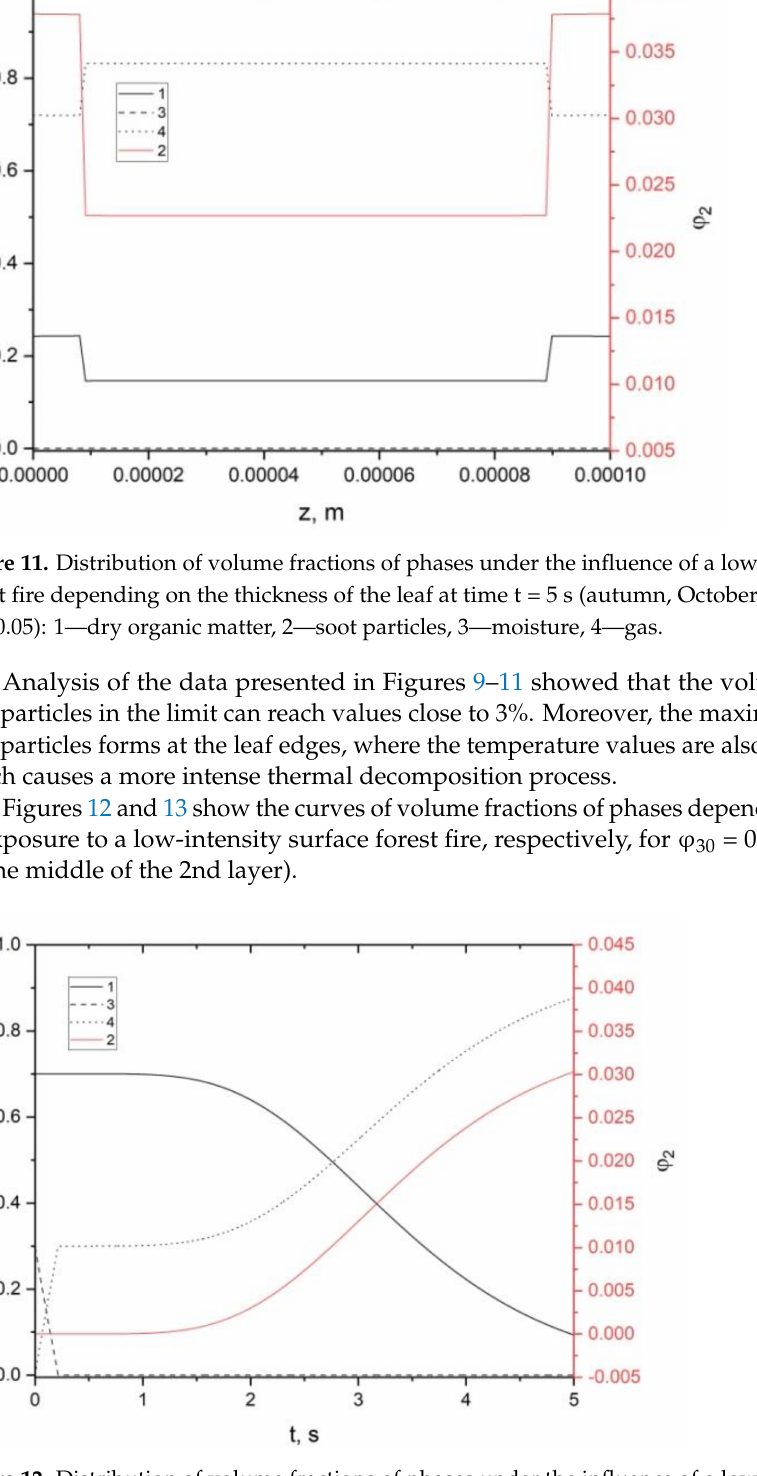
Figure 12. Distribution of volume fractions of phases under the influence of a low-intensity surface forest fire depending on time (summer, July, +20 ◦ C, ϕ 30 = 0.3, α s = 0.05): 1—dry organic matter, 2—soot particles, 3—moisture,